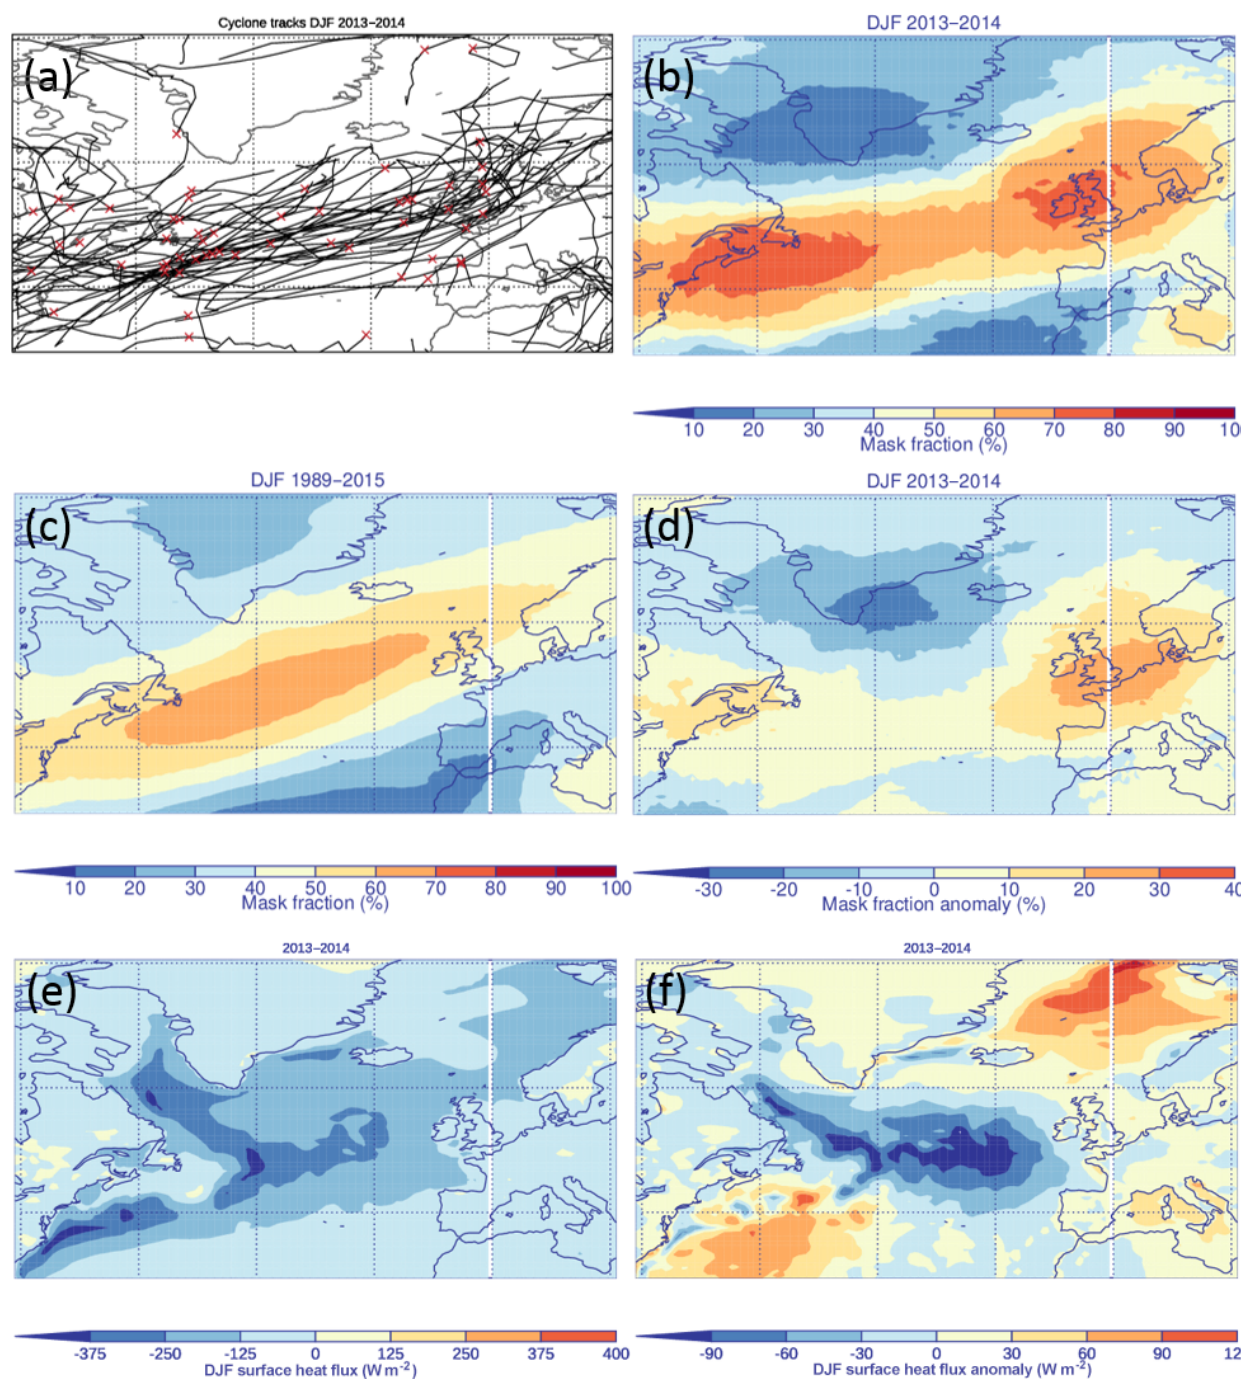
Figure 9. (a) 2013–2014 cyclone tracks (black) with position of maximum intensity (red crosses), (b) 2013–2014 fraction of time within cyclone mask, (c) 1989–2015 mask fraction, (d) anomalous mask fraction, (e) 2013–2014 Q N (Wm − 2 ) and (f) anomalous Q N (Wm − 2